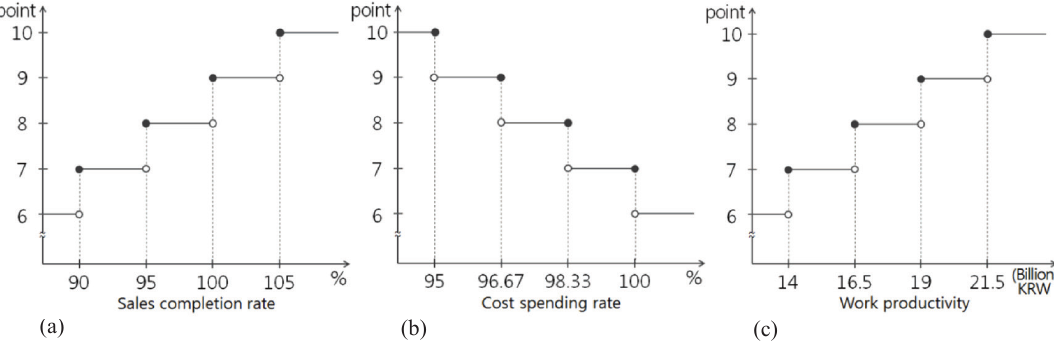
Fig. 1. The categorical scales for normalizing three sub-indicators: (a) the sales completion rate, (b) the cost spending rate, and (c) the work